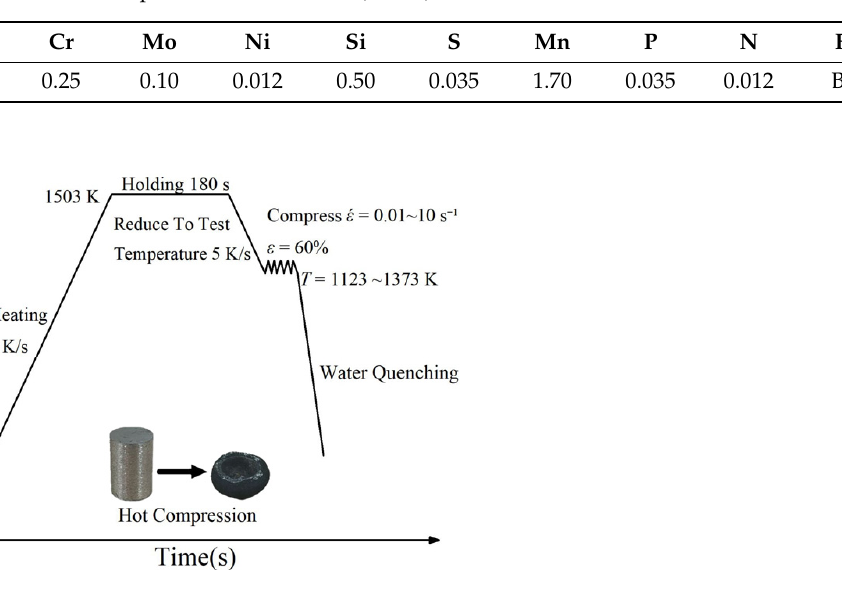
Table 1. Chemical composition of Q345 steel (wt/%).